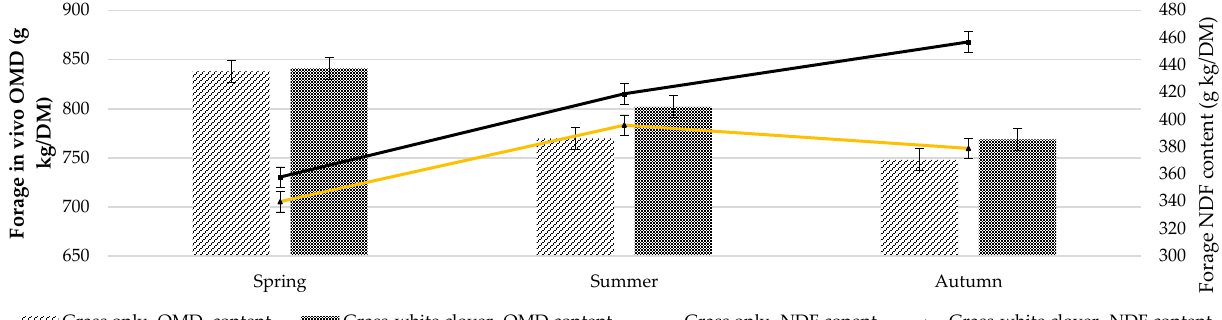
Figure 2. Forage crude protein content and daily N intake per kg body weight of grass-only and grass-white clover swards offered to individually housed sheep in spring (27 March – 29 April), summer (19 June – 22 July) and autumn (4 – 29 September) (measured > 4 cm).